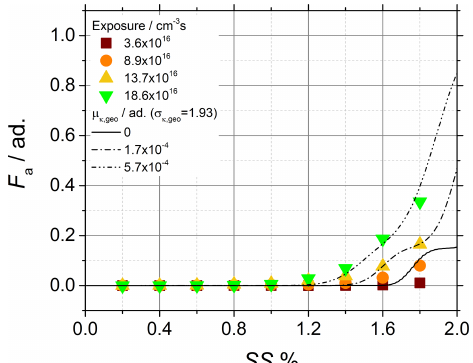
Figure 8. Soot sampled from the turbulent jet flame supplied with liquid kerosene at 130mm HAB. CCNc activation curves of the soot particles obtained after chemical aging with ozone and comparison of the experimental data (data points) to activation curves (lines) calculated by using p(κ) the and morphology-corrected d ve